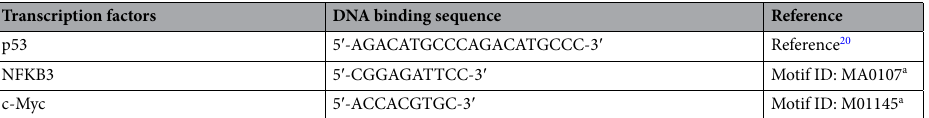
Table 3. DNA binding sequence of p53, NFKB3, and c-Myc as transcription factors. a Cited from the database site: http:// motif map. ics. uci. edu/. The binding sequences for NFKB3 and c-Myc are determined based on the binding consensus sequence in MotifMap. FTD is potentially incorporated into the thymine position (red colored “T”). The binding sequence for p53 is the same as the target DNA in Table 1.